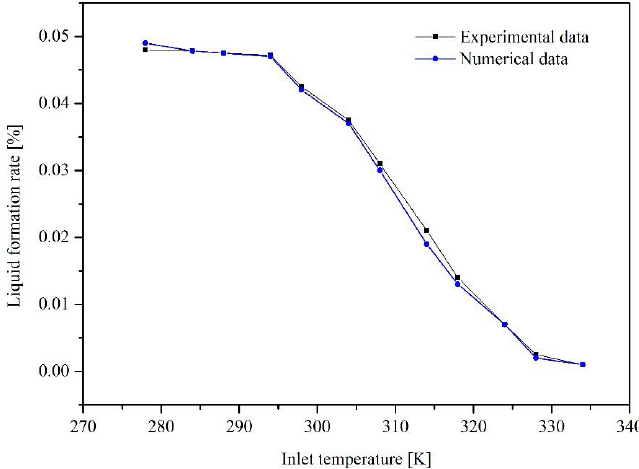
Figure 6. Variation in the liquid formation rate with the change in inlet temperature.